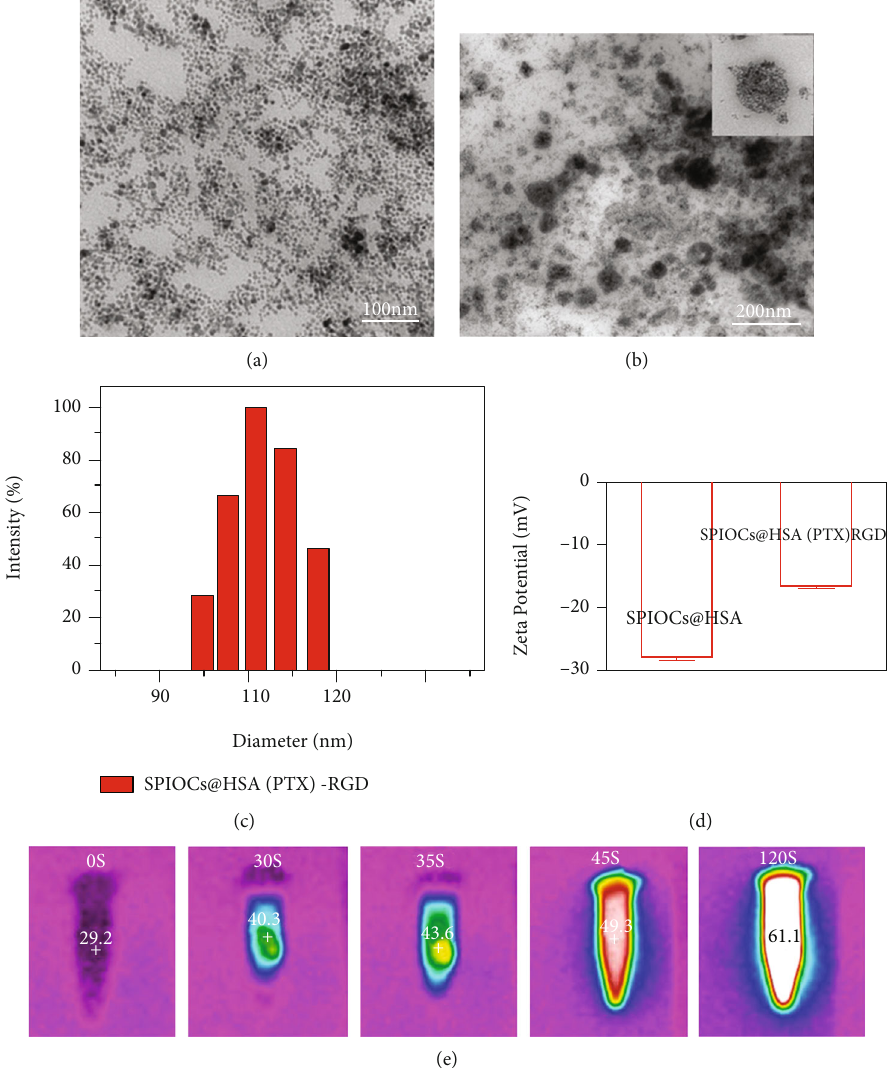
Figure 2: TEM morphologies of (a) ultrasmall superparamagnetic Fe determined by DLS; (d) zeta potential of SPIOCs@HSA and SPIOCs@HSA(PTX)-RGD NPs; (e) photothermal temperatures of the SPIOCs@HSA(PTX)-RGD irradiated by 808 nm light (0.5 W/cm 2